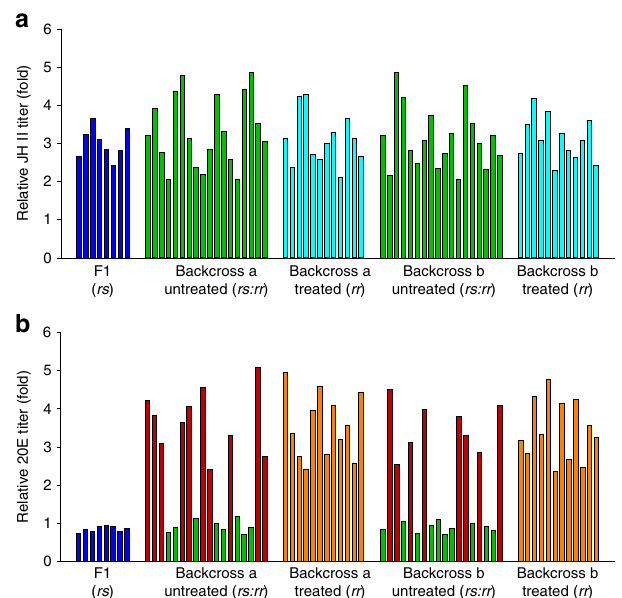
Fig. 8 Linkage of Cry1Ac resistance phenotype to increased 20E titers in the NIL-R strain. JH II ( a ) and 20E ( b ) titers for the F1, Cry1Ac-selected and non-selected backcross families are relative to hormone titers in the susceptible DBM1Ac-S strain. Both results using larvae of the subfamily generated from backcrossing a female from F1 and a male from the NIL-R strain (backcross family a) and using larvae of the subfamily generated from backcrossing a male from F1 and a female from the NIL-R strain (backcross family b) are shown. Source data are provided as a Source Data fi